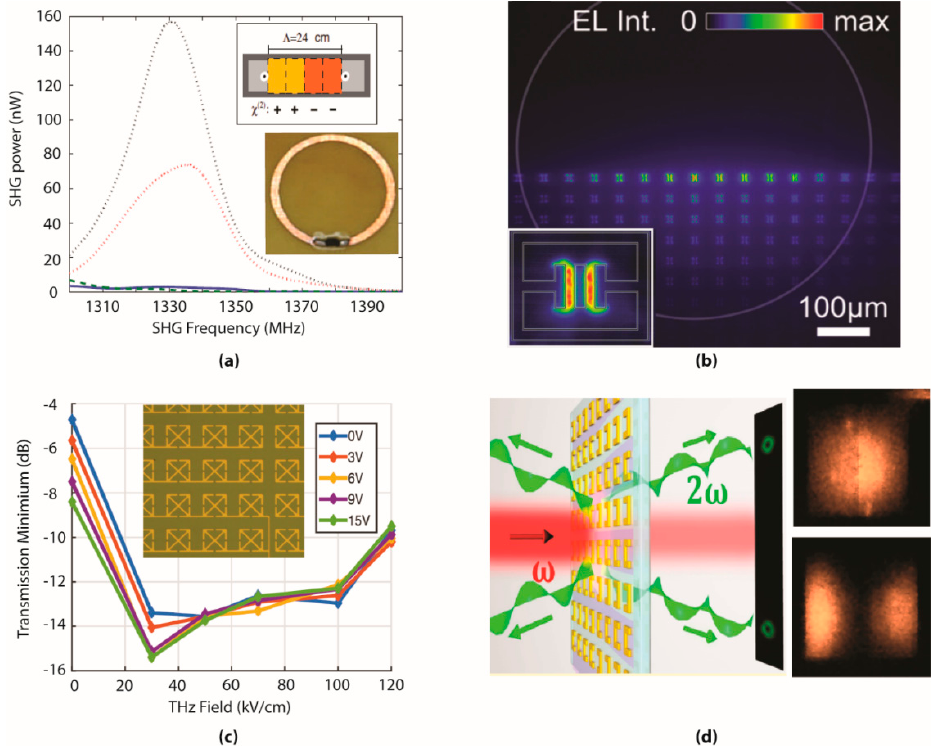
Figure 3. Field confinement in nonlinear metamaterials. ( a ) A nonlinear metamaterial for second harmonic generation at microwave frequencies. A varactor in the SRR capacitive gap (lower right inset) gives rise to the nonlinear response. ( b ) THz induced optical photoluminescence due to field confinement in SRRs (low left inset). Reprinted with permission from [48 – 49] . Copyright 2011 and 2014, respectively, by the American Physical Society. ( c ) Actively tunable MM devices on GaAs (center inset) substrates show strong nonlinear responses due to high incident fields and field confinement. For high incident fields, the overall modulation range drops to 0 dB, due to nonlinear effects [50] . ( d ) Nonlinear MMs in the near IR can also be implemented using field confinement. Here, field confinement induces second harmonic generation of an 800 nm beam and beam shaping of the 400 nm output. Reprinted with permission from [55] . Copyright 2016 by the American Chemical Society.